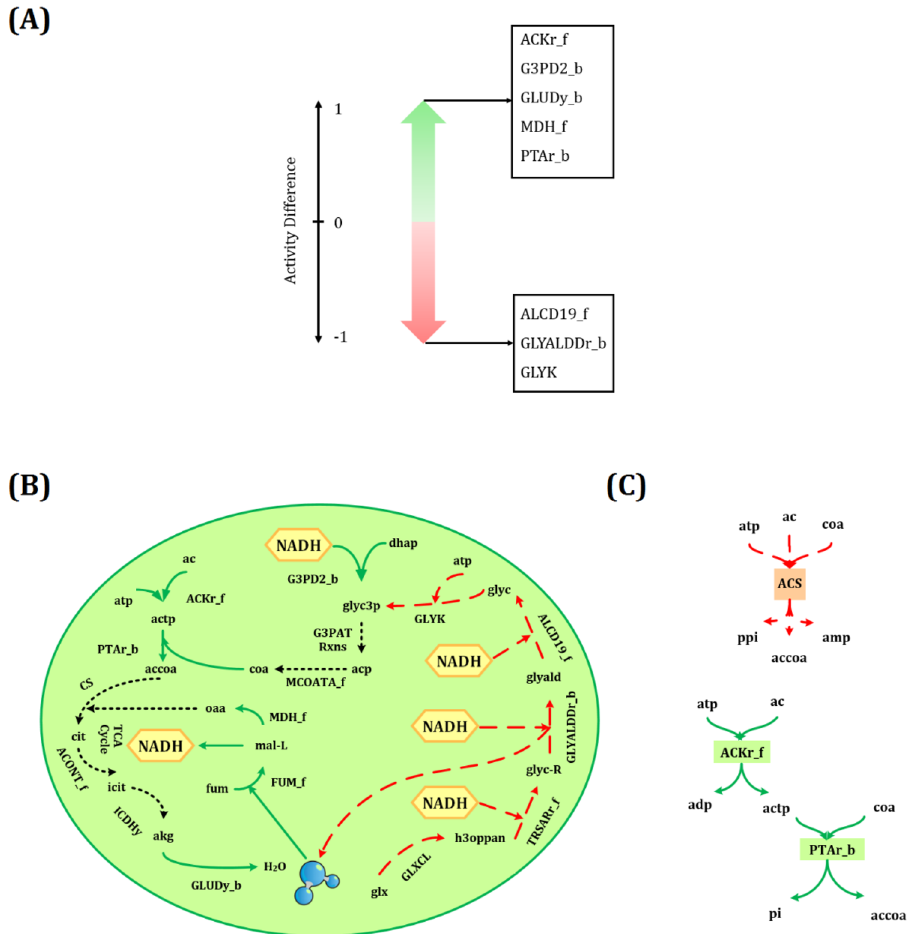
Figure 3. ( A ) Appropriate reactions for up-regulation (top) and down-regulation (bottom) predicted by the proposed systemic approach under phototrophic condition. ( B ) An overview of the metabolic pathways influencing NADH production; the reactions indicated by green arrows are suitable candidates for up-regulation, whereas red dashed lines should be down-regulated. Besides, reactions that do not contribute to NADH enhancement were shown with the black dotted line. ( C ) Acetate consumption via ACS, and series reactions of ACKr_f and PTAr_b. The suffixes _f and _b were used for reactions that occurred in the forward and backward directions, respectively. The entire name of all reactions and metabolites was given in the Supplementary file (Tables S3 and S4).